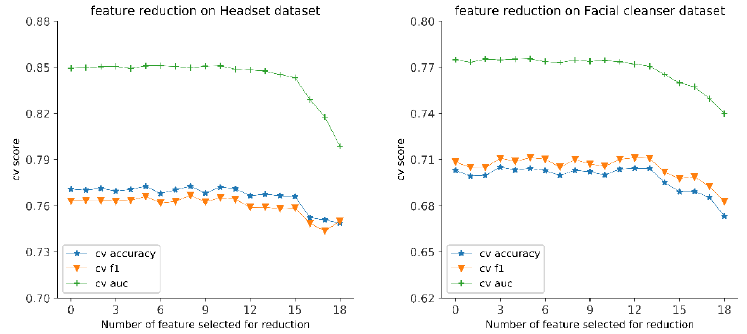
Figure 5. Feature reduction comparison on headset and facial cleanser datasets. (Source of data: https://www.amazon.cn).